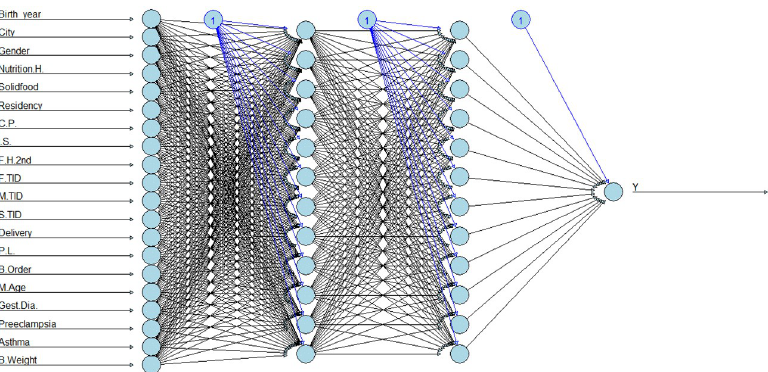
Fig 5. An optimal ANN model with 2 hidden layers with all input variables. P.L: pregnancy length, F.H.2nd: Family history of T1D with a second-degree relative, I.S.:Income Status, C.P.: Consanguineous Parents, M.Age: Maternal Age, B.Weight: Birth weight, B.Order: Birth Order.